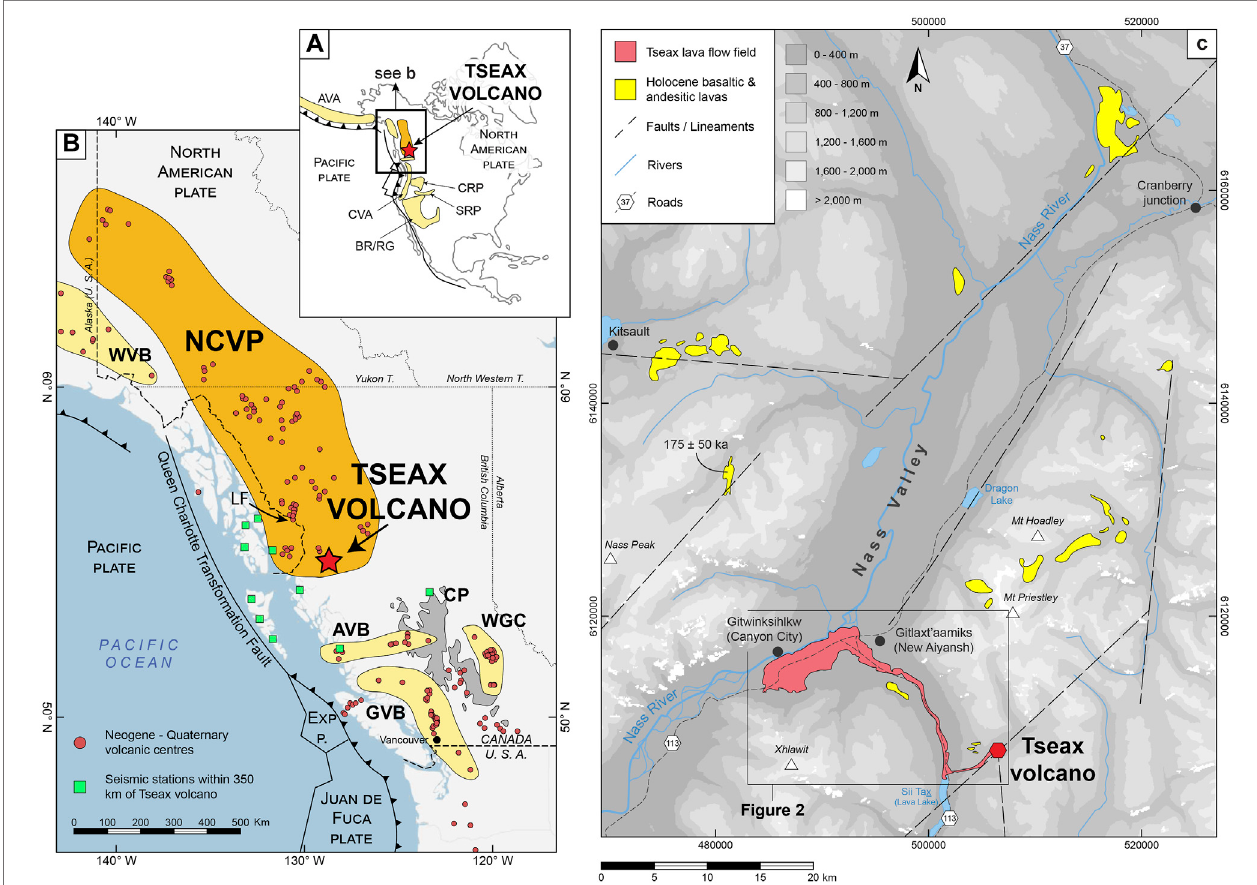
FIGURE 1 | Location of Tseax volcano in North America and western Canada. (A) The active volcanic regions in north-western North America. BR/RG, Basin and Range/RioGrandeRift;SRP,SnakeRiverPlain;CRP,ColumbiaRiverPlateau;CVA,CascadesVolcanicArc;AVA,AleutianVolcanicArc. (B) LocationofTseaxvolcanoin Northwest British Columbia. Tseax is located near the southern end of the Northern Cordillera Volcanic Province (NCVP). GVB, Garibaldi Volcanic Belt; WGC, Wells Gray – Clearwater Volcanic Field; AVB, Anaheim Volcanic Belt; WVB, Wrangell Volcanic Belt; Exp p, Explorer plate (Modi fi ed from Edwards and Russell 1999; Edwards and Russell 2000). (C) Identi fi ed Holocene volcanic rocks in the Nass Valley area (BC Hydro 1981; van der Heyden et al., 2000; Evenchick et al., 2008). The Tseax volcanic fi eld is highlighted in red. Faults and lineaments are from BC Hydro (1981), Evenchick et al. (2008). Note that Tseax volcano is roughly located at the intersection of N45 and north-south trending lineaments. Geographical coordinates are in UTM Zone 9N.